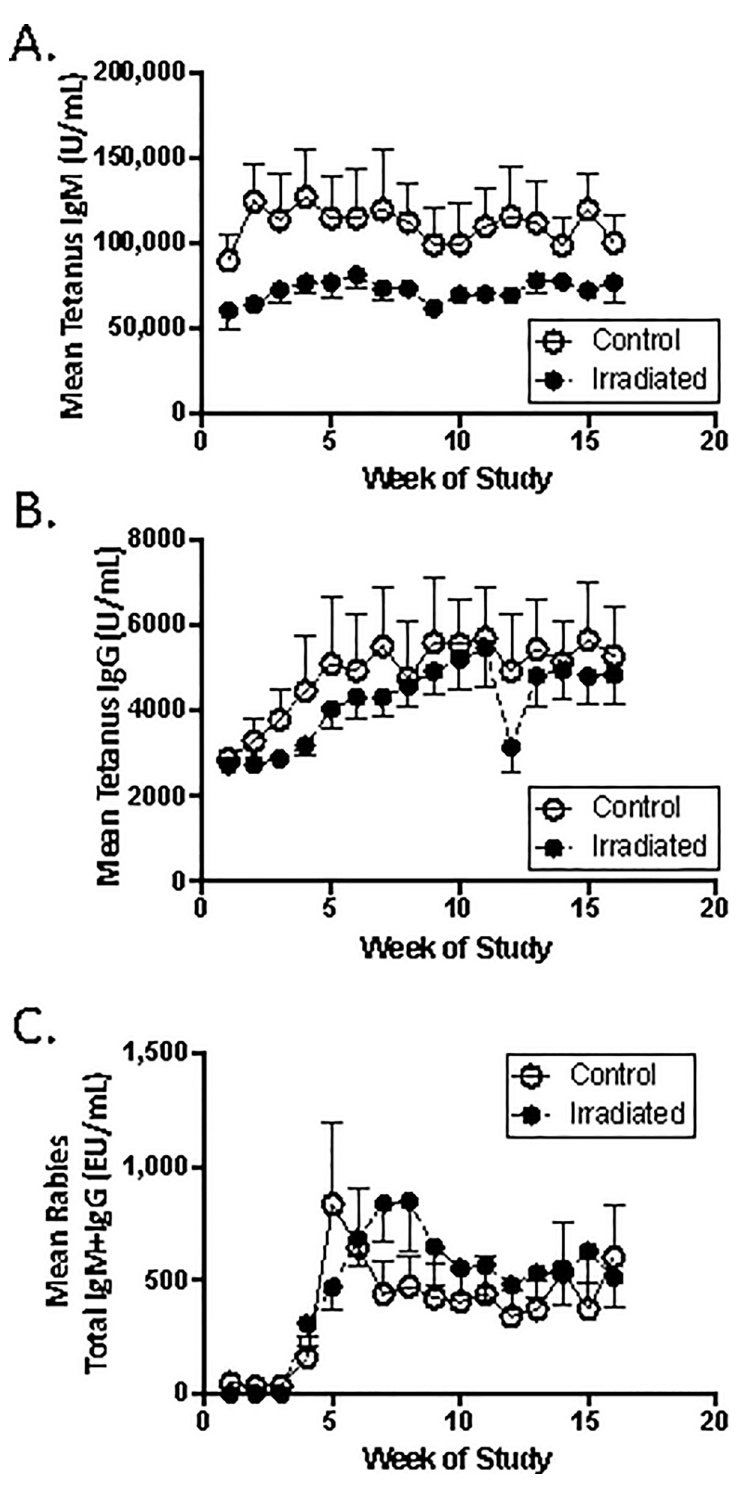
Fig 5. Antibody responses to tetanus and rabies antigens ~ 2 years post-irradiation. A . IgM responses to tetanus vaccine. B . IgG responses to tetanus vaccine. C . Combined IgM/IgG responses to rabies vaccine. Raw data are provided in S2